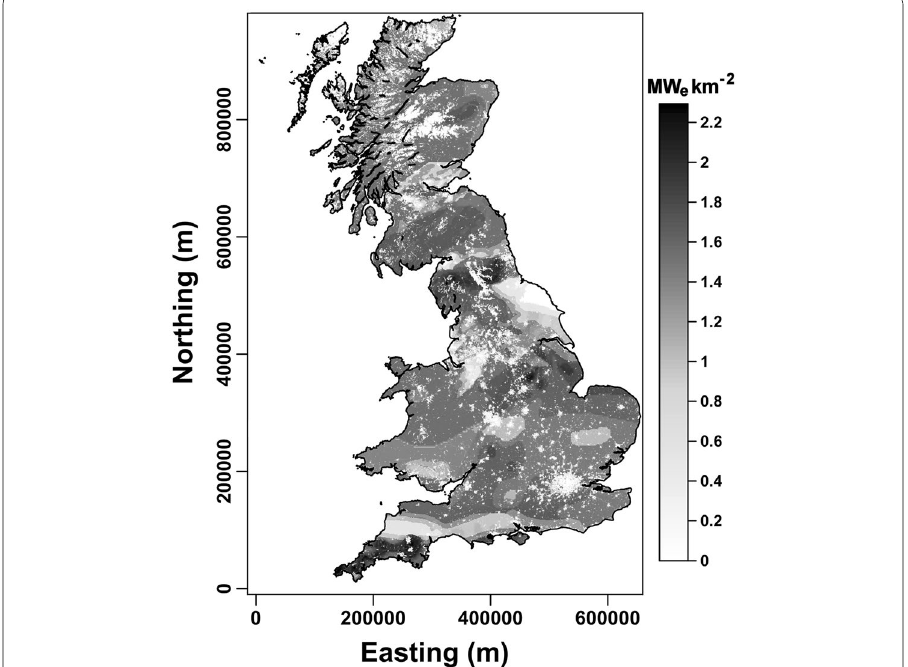
Fig. 7 Technical potential power density across Great Britain for the depth range 3.5-6.5 km. Areas with zero potential are mainly excluded as a result of land cover comprising urban settings and